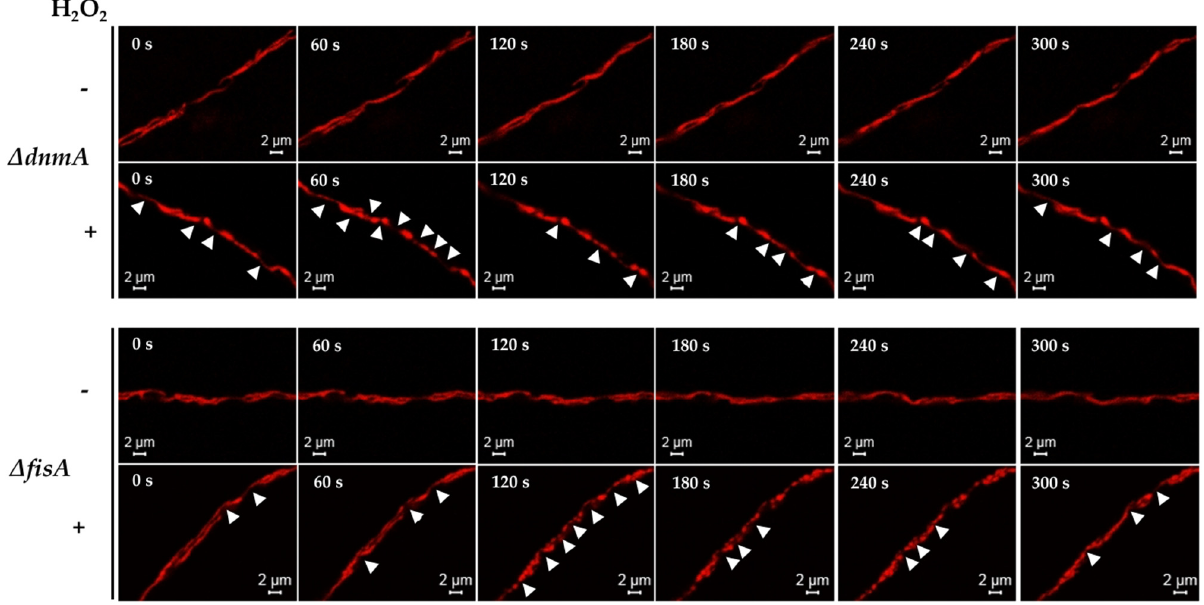
Figure 1. H 2 O 2 induces transient mitochondrial constrictions in the absence of the mitochondrial fission machinery. Mycelia from Δ dnmA (CVG1) and Δ fisA (CVG2) mutant strains grown for 18 h were treated or not with 5 mM H 2 O 2 for 20 min. After this, H 2 O 2 was removed; after another 10-min incubation, hyphae were observed at the indicated times using confocal microscopy. The mitochondrial matrix is labelled with mts::mCherry. The arrowheads point to some of the constriction events. In order to explore whether the H 2 O 2 -induced constriction-like structures were re- lated to mitochondrial membrane depolarization, we first exposed a wild-type strain to carbonyl cyanide m -chlorophenylhydrazone (CCCP), a well-known oxidative phosphor- ylation uncoupler [37]. Like H 2 O 2 , CCCP was able to induce a massive mitochondrial di- vision in a wild-type background, and the mitochondria did not recover their filamentous form after prolonged incubation times (Figure S1). When ∆ dnmA and ∆ fisA mutants were treated with CCCP, it induced mitochondrial constriction-like structures in 87 and 89% of the hyphal tips observed in both ∆ dnmA and ∆ fisA mutants, respectively (Figure S2). Ob- servations in vivo showed that CCCP induced constriction-like structures much faster than H 2 O 2 , and that the changes in mitochondrial morphology were more dramatic in the ∆ fisA mutant (Figure 2). Notably, these CCCP-induced changes were not reversible, and the round structures remained up to 400 s and beyond. Because H 2 O 2 induces similar re- sponses in ∆ dnmA and ∆ fisA mutants, we decided to focus our analysis using only ∆ dnmA mutants. In order to follow mitochondrial depolarization more directly, we incubated ∆ dnmA mutant cells—in which the outer mitochondrial membrane was labelled with GFP—in the presence of the voltage sensor tetramethylrhodamine methyl-ester (TMRM), which is rapidly sequestered by the negatively charged mitochondrial membrane poten- tial. The results in Figures 3 and S3 show that after this incubation, about 95% of the hy- phae contained TMRM-stained mitochondria. Under these conditions, H 2 O 2 induced a gradual loss of mitochondrial membrane potential. After 5, 8, 15 and 20 min in H 2 O 2 , the number of hyphae stained with TMRM decreased to 87, 76, 20 and 6%, respectively. In contrast, in the presence of CCCP, mitochondrial membrane potential was lost after only 5 min of incubation (Figure 3). The use of strains with GFP-labelled outer mitochondrial membrane (Figures 3, 4, S4 and S5) allowed us to confirm that the mitochondrial con- striction-like structures observed in Figures 1 and 2 correspond to actual constrictions pre- sent in non-dividing mitochondria; they will be named as such. Notably, H 2 O 2 -induced mitochondrial constrictions were evident at around 15 min, while with CCCP they were already present after 5 min (Figure 3).